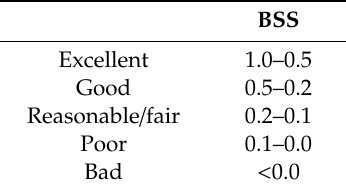
Table 2. Classification table for the Brier Skill Score (BSS) as proposed by [59]. (Adapted from [59], with permission from Elsevier, 2004).